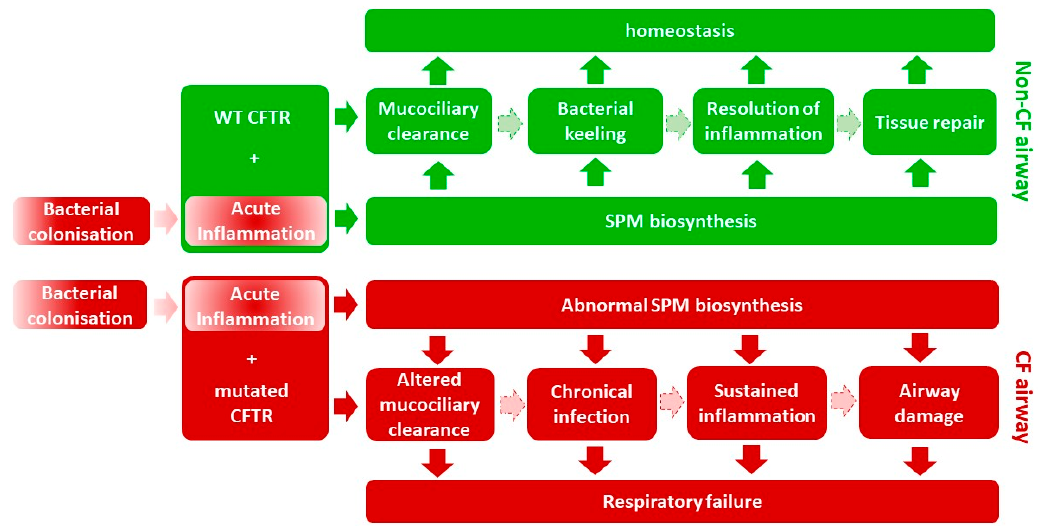
Figure 3. Novel hypothetical model for cystic fibrosis (CF) airway pathogenesis. In CF and non-CF airway bacterial infection triggers inflammation. In non-CF cells (top), self-limited inflammation involves the biosynthesis of specialized pro-resolving eicosanoid mediators (SPM) that enhance mucociliary clearance, bacterial killing, resolution of inflammation, and tissue repair, resulting in tissue returning to homeostasis (green). In CF cells (bottom), after initiation of inflammation, the eicosanoid class switching is altered and SPM are abnormally produced. This results into a defective mucociliary clearance, sustained inflammation, inefficient bacterial killing and tissue repair that lead to respiratory failure (red). This model enhances the role of SPM in the resolution phase of inflammation compared to the impact of dehydration and altered mucociliary clearance.